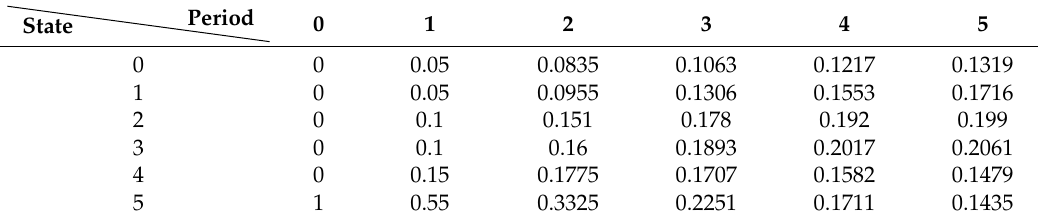
Table A6. Probability distribution of component 6 using the SMV